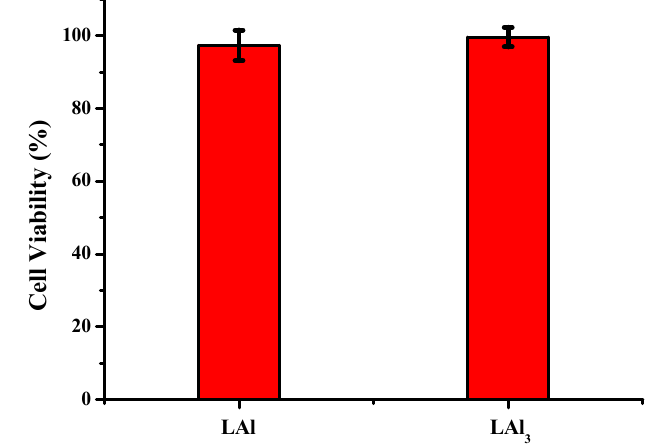
Figure 4. Cytotoxicity of the two indicated complexes toward HeLa cells using CCK-8 assay. HeLa cells were incubated with 5 μ M dye for 24 h in complete media (Mean ± SD).